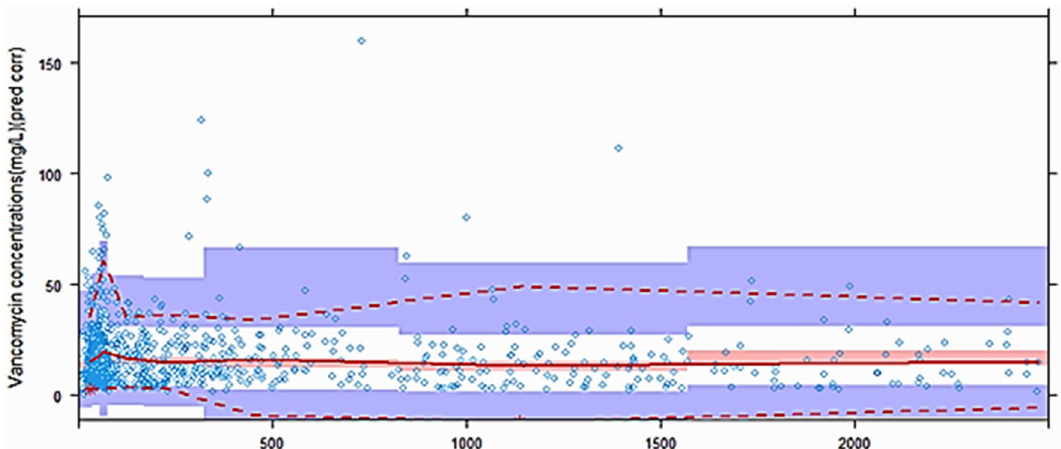
Figure 2. Prediction-corrected visual predictive check for vancomycin. A thousand simulations were performed. Prediction-corrected observed concentrations are shown as open circles. The middle solid, lower dashed, and upper dashed lines represent the median, 2.5th, and 97.5th percentiles for the observed data, respectively. The shaded areas represent a 95% confidence interval for a simulated predicted median, 2.5th, and 97.5th percentiles constructed from 1000 simulated datasets of individuals from the original dataset.